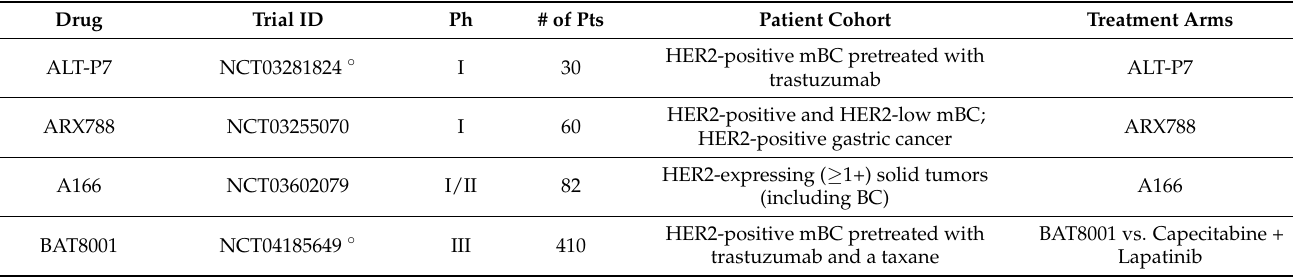
Table 1. Summary of current clinical trials investigating antibody drug conjugates targeting HER2. Legend: ◦ Active, not recruiting; * Not yet recruiting. Abbreviations: ID, identifier; #, number; pts, patients; BC, breast cancer; mBC, metastatic breast cancer; HER2, human epidermal growth factor receptor 2; CT, chemotherapy; ET, endocrine therapy; HR, hormone receptor; TPC, treatment of physician’s choice; NSCLC, non-small cell lung cancer; mTNBC, metastatic triple negative breast cancer; eBC, early breast cancer; T-DM1, trastuzumab emtansine; PD-L1, programmed death-ligand 1. Source: ClinicalTrial.gov (accessed on 15 March